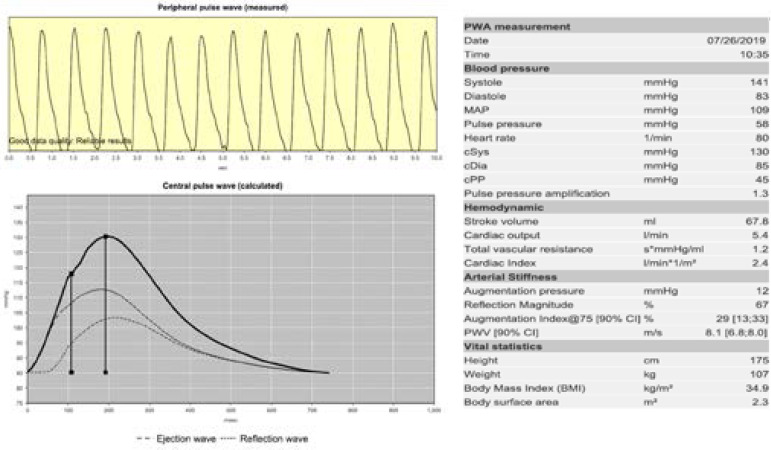
Analysis of a patient. cDia=central diastolic pressure; CI=confidence interval; cPP=central pulse pressure; cSys=central systolic pressure; MAP=mean arterial pressure; PWA=pulse wave analysis; PWV=pulse wave velocity